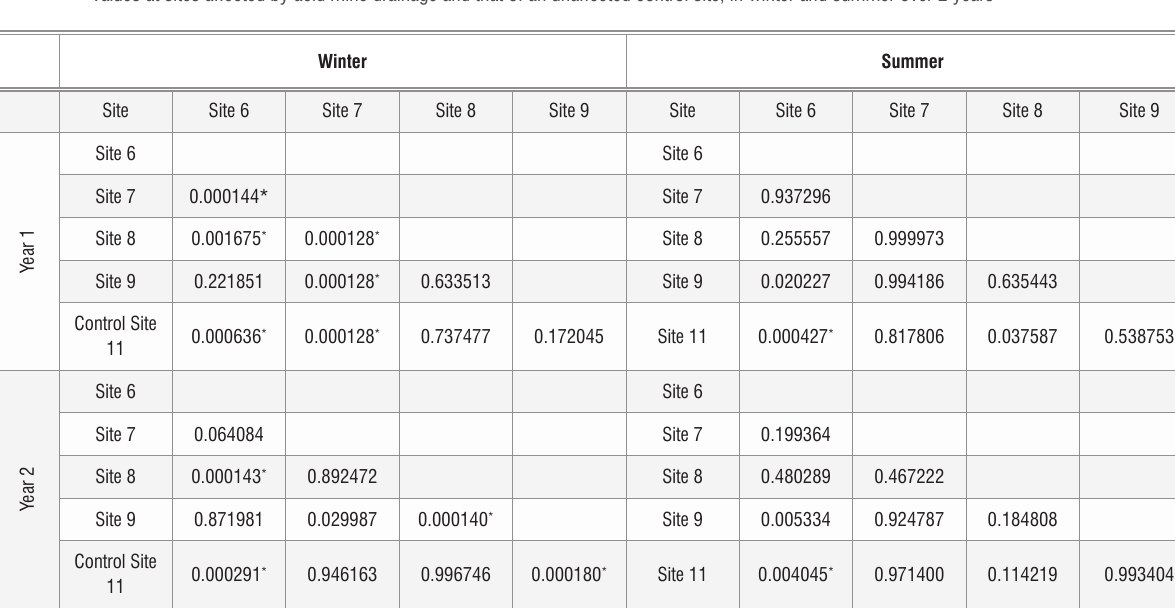
One-way analysis of variance (Tukey’s honest significant difference test) results of comparisons between normalised difference vegetation index values at sites affected by acid mine drainage and that of an unaffected control site, in winter and summer over 2